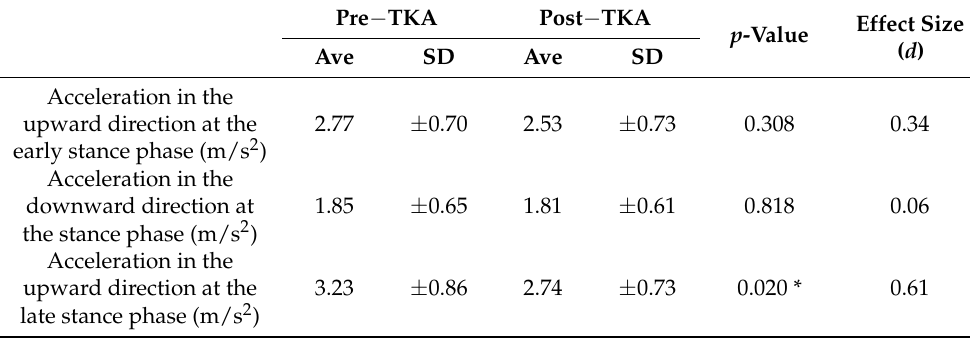
Table 5. Changes in vertical acceleration during the walking stance phase.